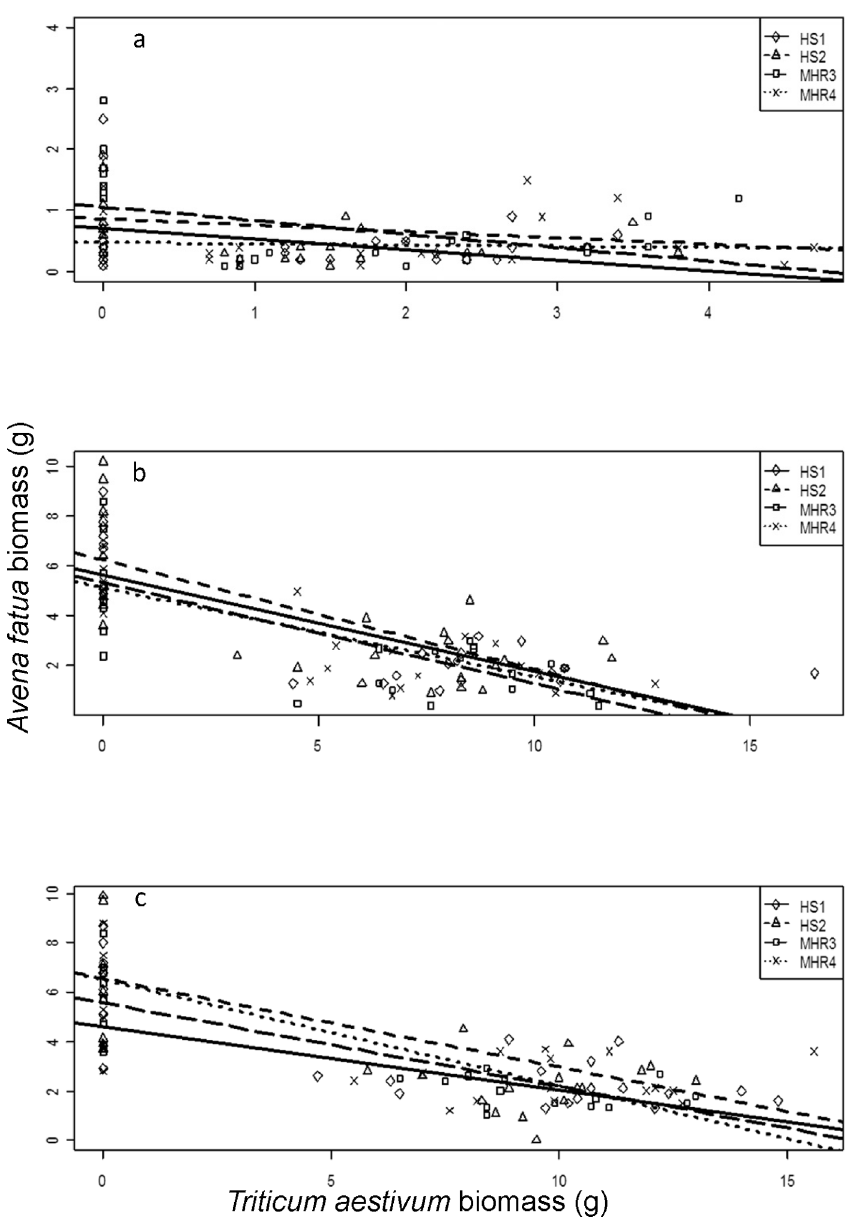
Figure 1. Effects of Triticumaestivum competition and nitrogen on Avenafatua biomass. Nitrogen fertilizer rates (N) are (a) 0, (b) 50 and (c) 100 kg N ha 2 1 . HS1 and HS2 are herbicide susceptible A. fatua populations and MHR3 and MHR4 are multiple herbicide resistant populations. n=8 for each N, T. aestivum competition, and A. fatua combination.